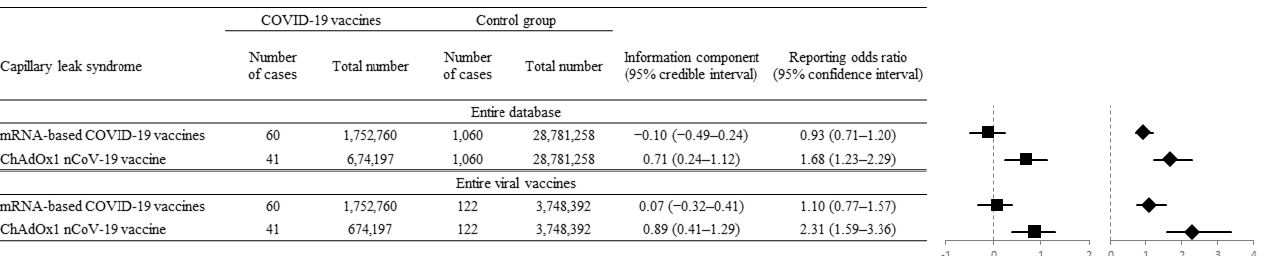
025 and ROR 025 , a significant potential signal of disproportionality of